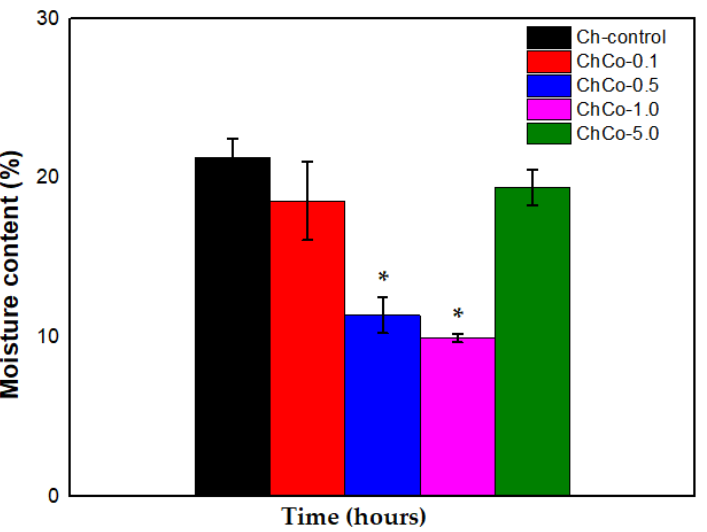
Figure 6. Percentage of membrane moisture with analysis of the ANOVA Test ( p < 0.05; DF = 4) and the Tukey Test. The asterisk indicates the sample with significant statistical difference ( p < 0.05).